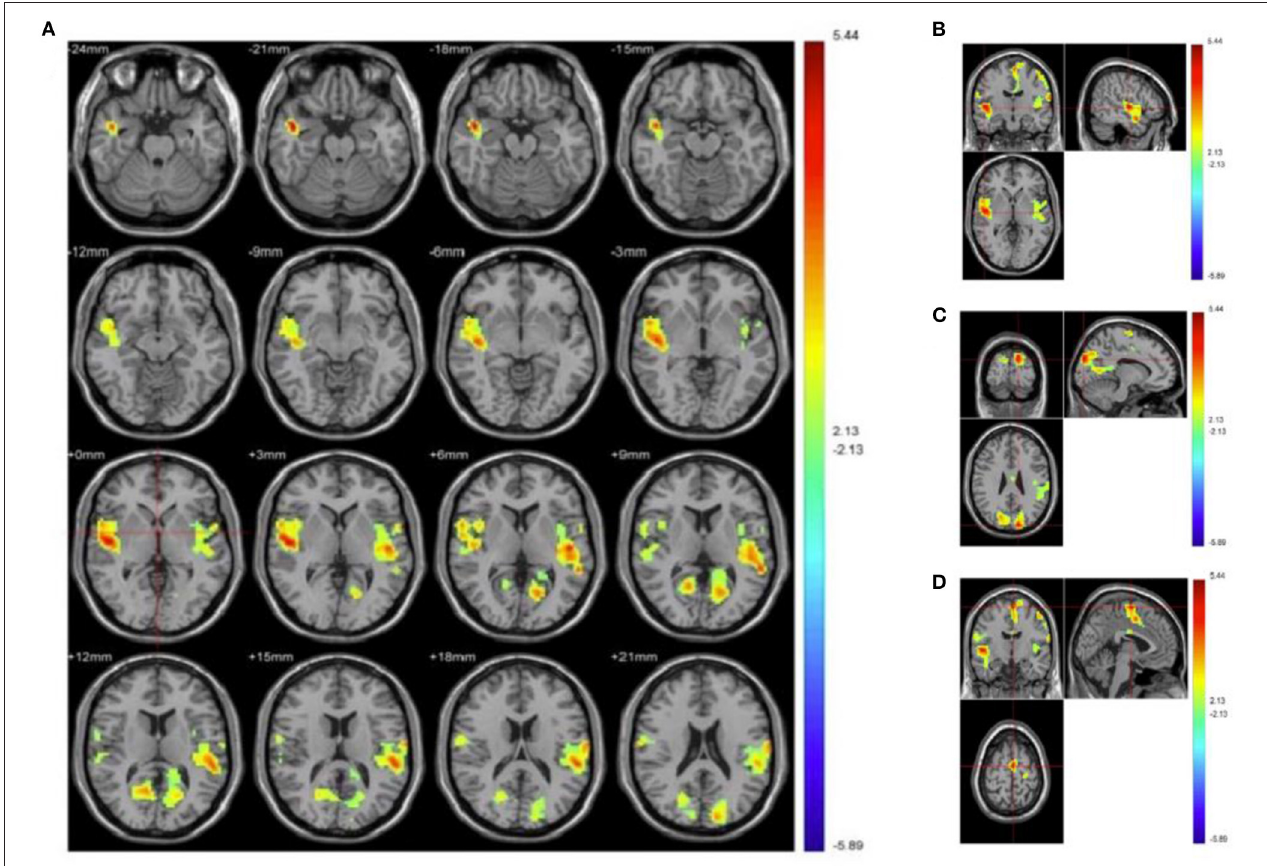
FIGURE 2 | Increased and decreased activation of PMS patients’ brain regions than healthy controls when processing depression vs. neutral pictures. (A) Depicts overall activation of the brain area by negative emotional picture task in PMS patients. (B) Manifests bilateral temporal lobe. (C) Illustrates bilateral precuneus, posterior cingulate, and cuneiform. (D) Demonstrates the brain areas activated in motor areas. Red indicates enhanced activation of brain regions in PMS patients, while blue indicates that activation is decreased.